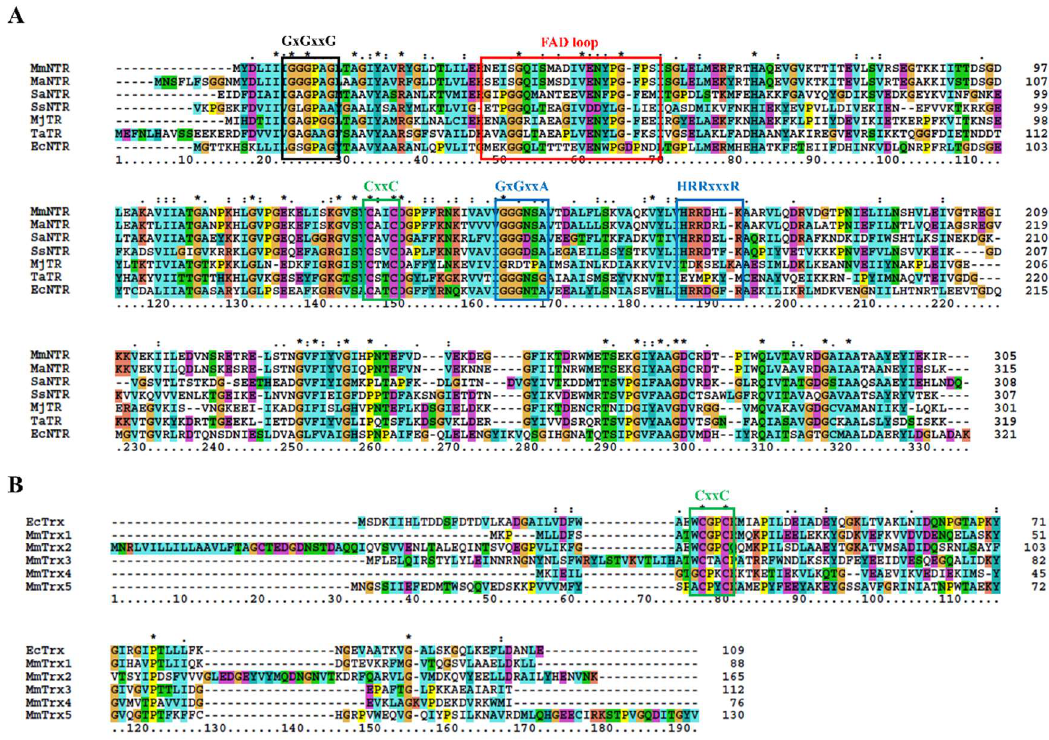
Figure 1. Protein multiple sequence alignment of selected NADPH-dependent Trx reductase (NTR) ( A ) and Trx ( B ). The positions of the conserved residues involved in FAD- and NADPH-binding are marked in panel ( A ) in black and blue, respectively; the region implicated in FAD coordination is depicted in red (see also Figure 3A below). The CxxC redox-active site motifs are shown in green in ( A , B ). Asterisks and column colors are assigned according to the ClustalX program’s standard parameters. The ruler below indicates the amino acid position in the alignment. On the right, the number of amino acids for each Trx is stated. The figure includes the amino acid sequences from ( A ) Methanosarcina mazei NTR (MmNTR), Methanosarcina acetivorans NTR (MaNTR), Staphylococcus aureus NTR (SaNTR), Sulfolobus solfataricus NTR (SsNTR), Methanocaldococcus jannaschii TR (MjTR), Thermoplasma acidophilum TR (TaTR), Escherichia coli NTR (EcNTR); and, ( B ) E. coli Trx (EcTrx), and five Trx sequences from M. mazei (MmTrx1–MmTrx5). Table 1. The thioredoxin system composition in M. mazei and a comparison with the M. acetivorans system. M.